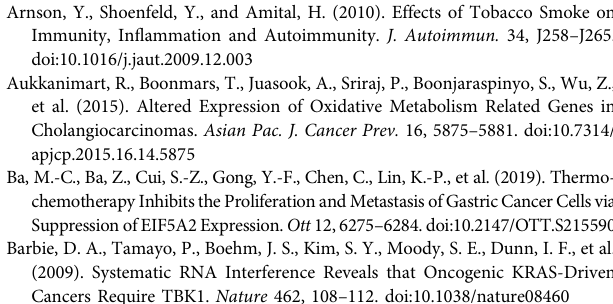
Supplementary Figure 2 | KM curves showed a difference in OS among patients with different risk scores, and an independent prognostic analysis was applied to analyze the effects of risk scores on OS along with other clinical features. Supplementary Figure 3 | ROC curves of the ability of the smoking-related model and other clinical features to predict patient ’ s 1-, 3- and 5-years OS in each cancer type. Supplementary Figure 4 | Construction of nomograms for predicting OS in patients and evaluation of its accuracy. Nomograms were developed by combining the smoking-related model with age, gender, and stage to predict the 1-, 3- and 5-year OS of patients in each cancer type. Calibration diagrams were employed to establish the consistency of the nomogram prediction OS of patients with real results. Supplementary Figure 5 | KM curves showed a difference in DSS among patients with different risk scores, and an independent prognostic analysis was applied to analyze the effects of risk scores on DSS along with other clinical features. Supplementary Figure 6 | KM curves showed a difference in PFI among patients with different risk scores, and an independent prognostic analysis was applied to analyze the effects of risk scores on PFI along with other clinical features. Supplementary Figure 7 | ROC curves of the predictive ability of the prognostic model predicting 1-, 3- and 5-years DSS (A – G) and PFI (H – N) of patients in each cancer type. Supplementary Figure 8 | Construction of nomograms for predicting DSS of each cancer patient as well as evaluation of its accuracy. Nomograms were constructed by use of the smoking-related model and other clinical indicators to predict the DSS of each cancer patient. Calibration curves were used to evaluate the consistency of nomogram prediction patient DSS with real results. Supplementary Figure 9 | Construction of nomograms for predicting PFI of each cancer patient as well as evaluation of its accuracy. Nomograms were constructed